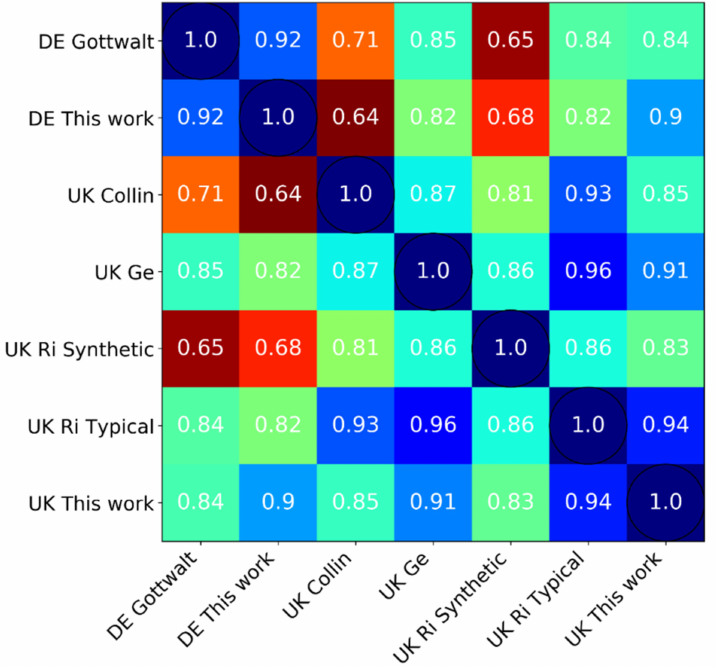
Figure A8. The coefficient of determination R 2 between this work and data reproduced from [8], Gottwalt et al.: 2011; [9], Collin et al.: 2012, [4], Richardson et al.: 2010 and [15], Ge et al.: 2016. All profiles are scaled to the same daily consumption and shifted to the same timezone. UK Collin only contains the load curve during winter months and UK Ri Synthetic does not contain thermal